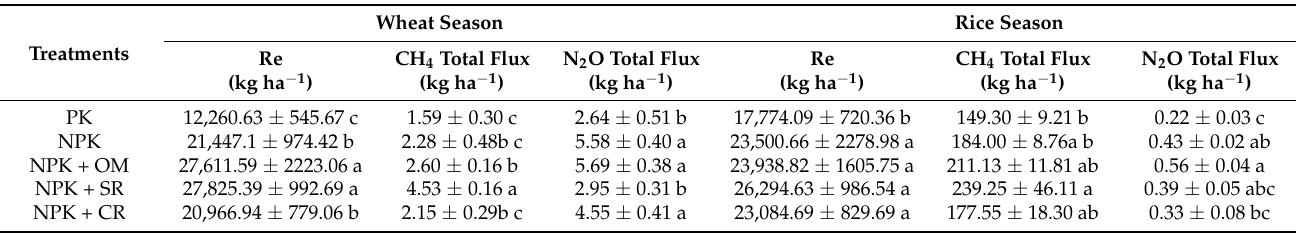
Table 2. Effects of different fertilizer treatments on total emissions of CO 2 , CH 4 and N 2 O during wheat season and rice season, respectively.